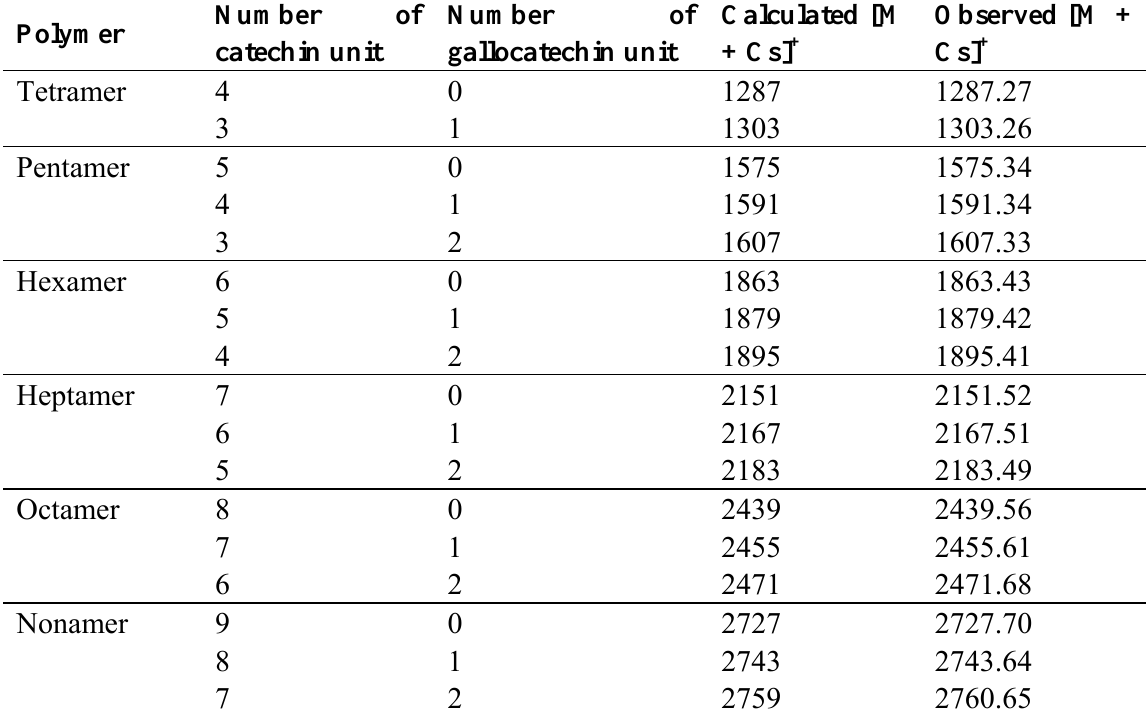
Table 4. Observed and calculated masses of heteropolyflavan-3-ols by MALDI-TOF